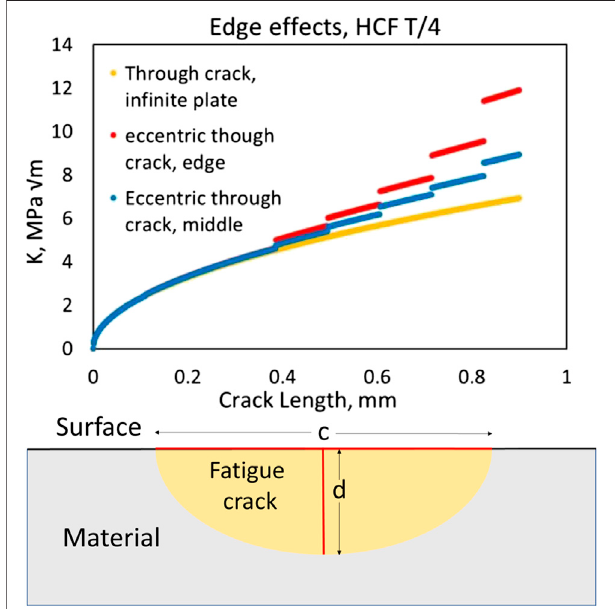
FIGURE 4 | (A) Comparison of SIF results for varying crack location and plate size. Note that the solutions for the eccentric crack are piecewise due to the tabular look up format for some of the data. (B) Diagram of surface fatigue crack.